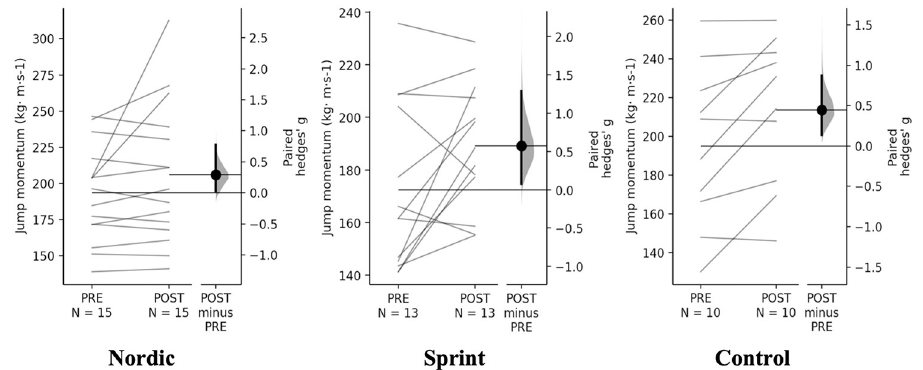
Fig 7. Gardner-Altman estimation plots identifying Pre- and Post-intervention individual changes for jump momentum and Hedge’s g effect size with the 95% CI indicated by the ends of the vertical error bar.